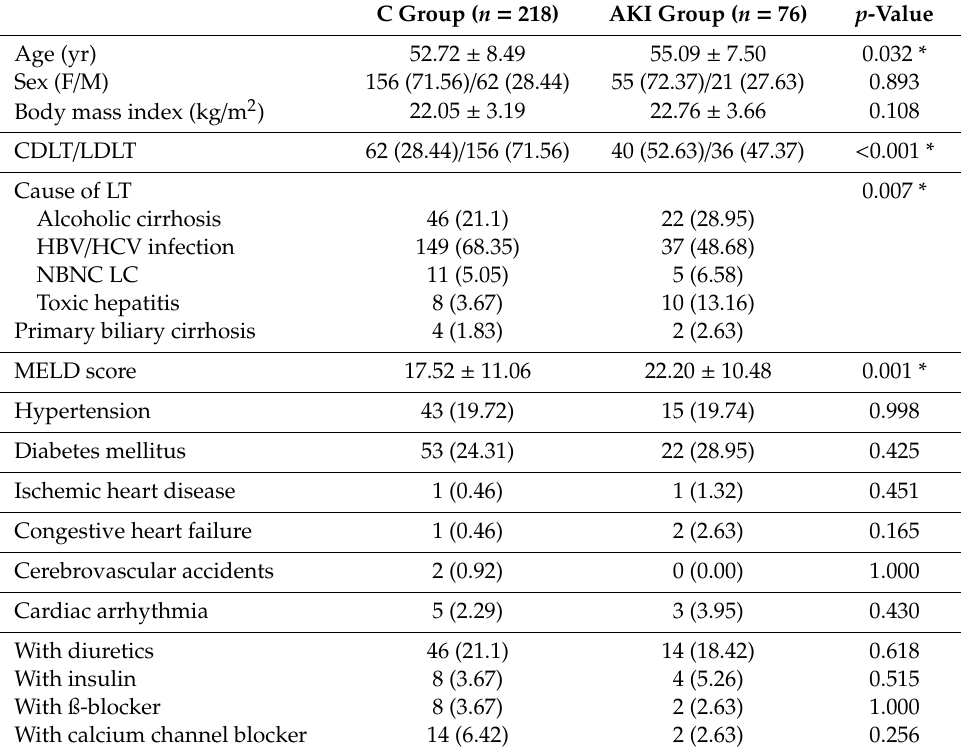
Table 1. Characteristics of patients undergoing liver transplantation.